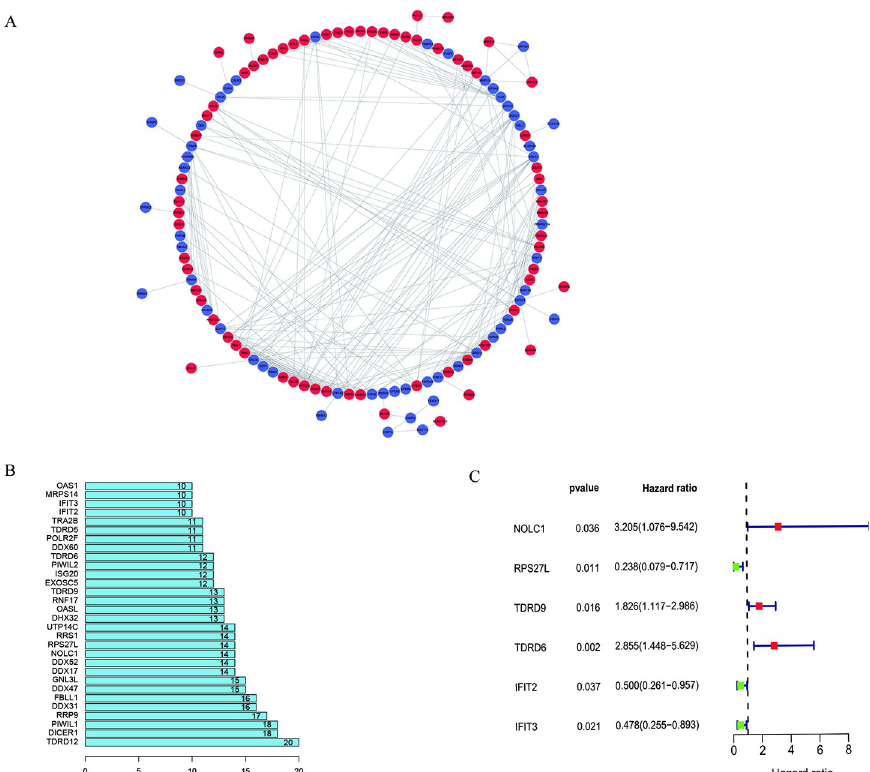
Fig 2. PPI network and key prognostic gene. (A) PPI network for RBPs. blue: down-regulated genes, red: up- regulated genes; (B) Top 30 nodes in PPI network with the number of interactions; (C) Prognostic-related genes in TCHA.